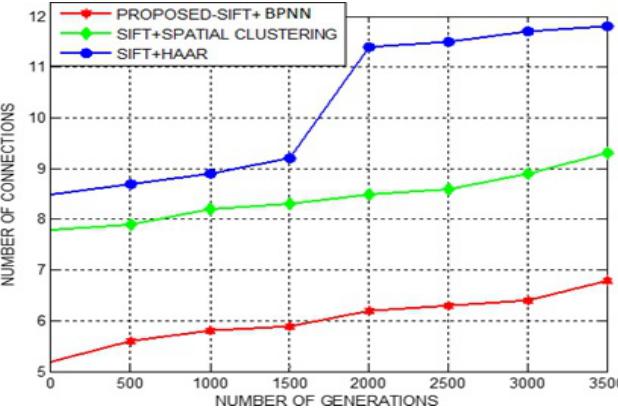
Figure 10. Number of connections utilized in the proposed